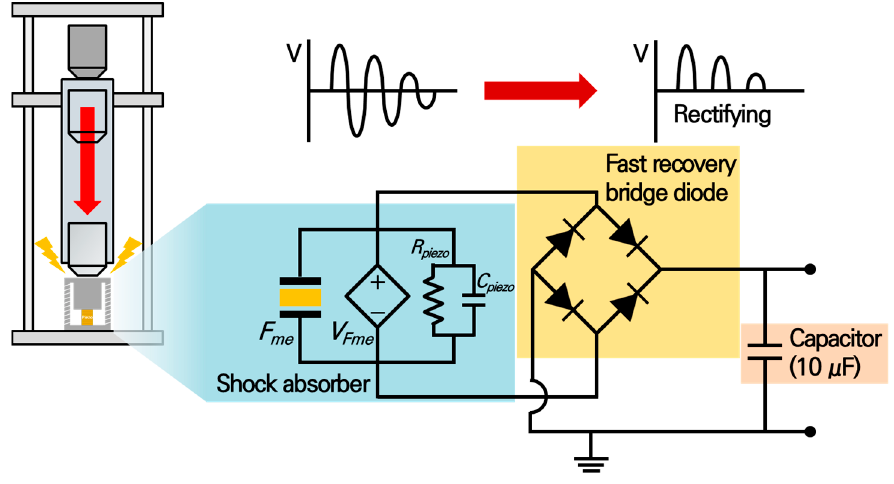
Figure 7. The schematic diagram of the energy storing system with a fast recovery bridge diode and shock absorber.